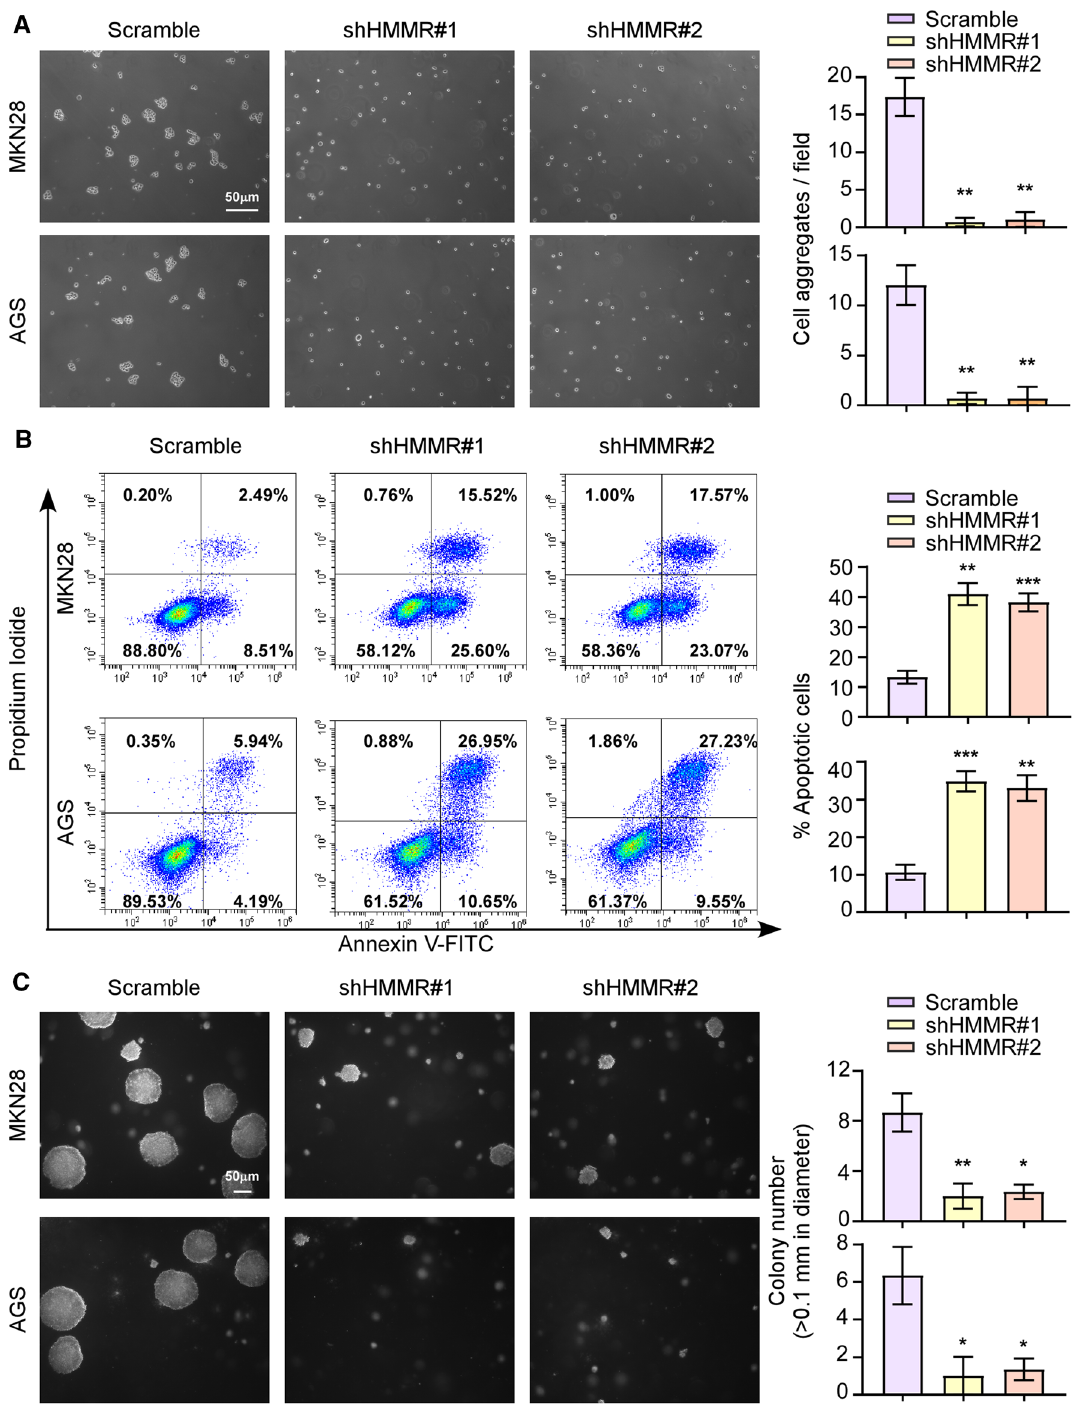
Fig. 1 HMMR promotes cell survival and growth by increasing cell–cell interactions. A Representative images of cell aggregates formation of MKN28 and AGS cells with or without HMMR silencing were shown. B The percent of anoikis cells in indicated groups were shown. C Anchorage-independent growth ability was reduced in HMMR-silenced cells. Quantification of the soft agar colony formations was based on colonies > 0.1 mm in diameter. Each bar represents the mean ± SD of three independent experiments. P < 0.05 was considered statistically significant. * P < 0.05; ** P < 0.01; *** P <